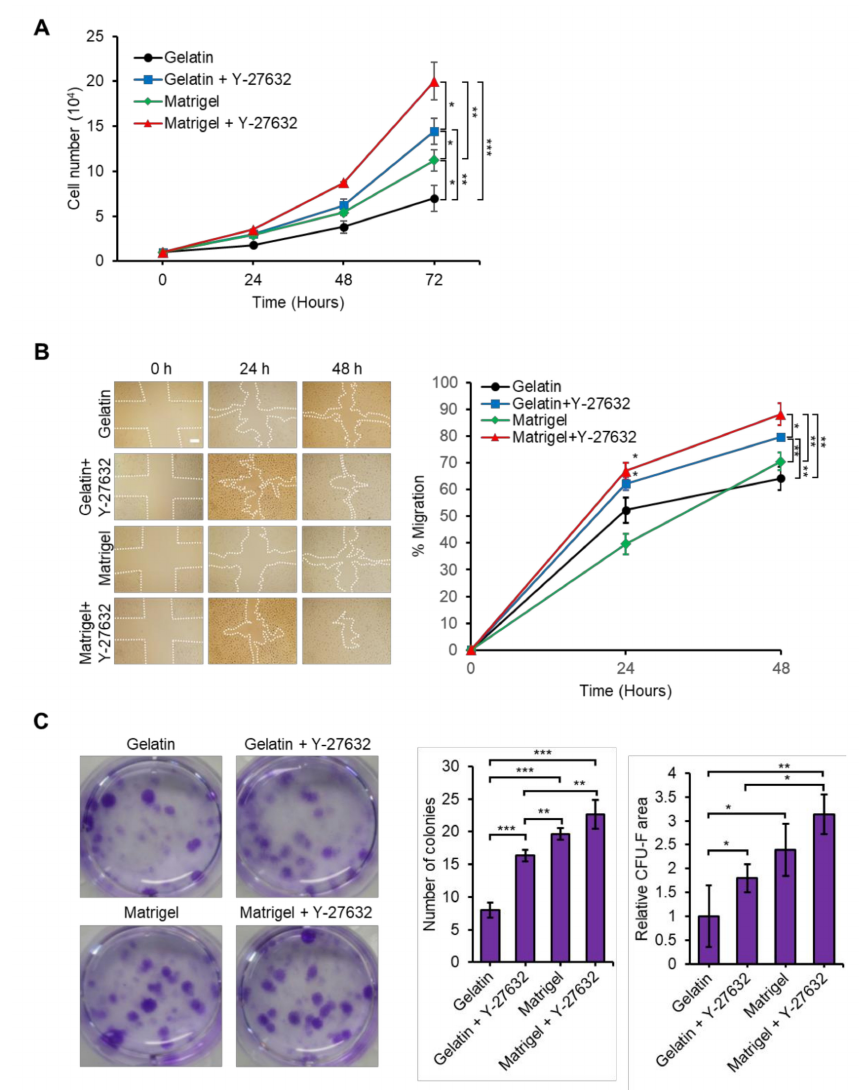
Figure 3. Y-27632 and Matrigel enhances the properties of USCs. ( A ) Growth curve of gelatin, gelatin + Y-27632, Matrigel, Matrigel + Y-27632 treated USCs at di ff erent time points. ( B ) Wound healing assay. Cell migration was assessed by the recovery of the scratch. Gelatin, gelatin + Y-27632, Matrigel, Matrigel + Y-27632 treated USCs, respectively. Scale bar: 200 µ m. ( C ) Colony forming unit fibroblast (CFU-F) assays. At each group, representative plates of CFU-F colonies stained with crystal violet are shown (left panel). CFU-F colonies were counted after culture for 14 days. Asterisks indicate significant di ff erences. The data are presented as fold changes compared with the gelatin group (right panel). n = 3 biological samples. (* p < 0.05, ** p < 0.01, *** p <